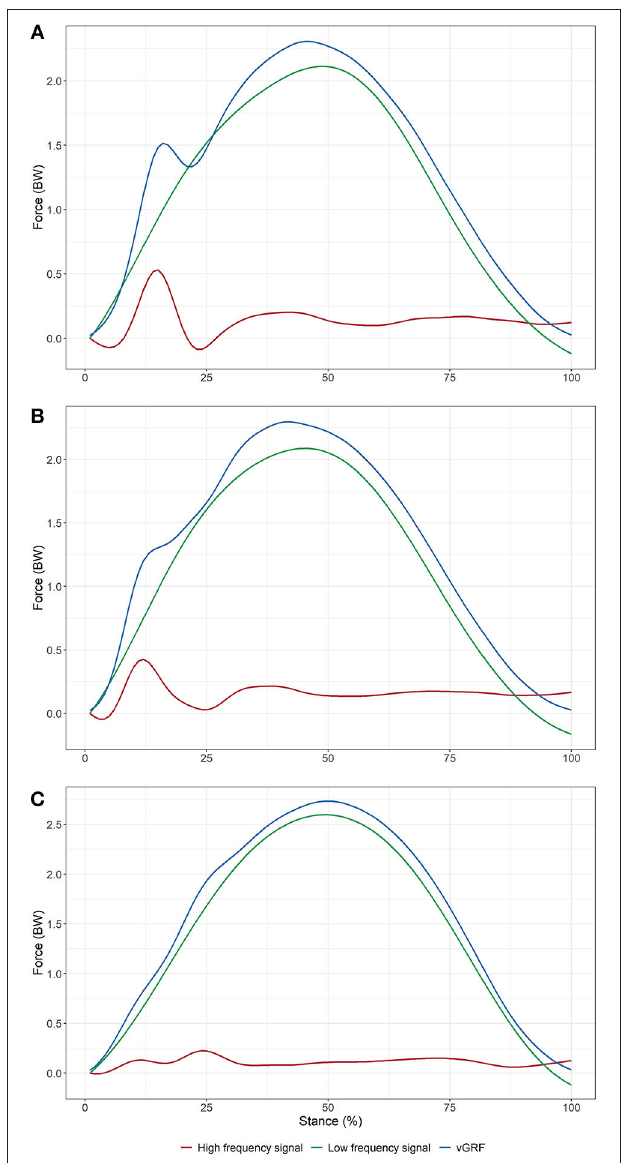
FIGURE 2 | Exemplary ensemble-averaged curves from three participants with 100% (A) , 50% (B) and 0% (C) of their steps with an impact peak identified on the vertical GRF signal, respectively. Blue line is the participant’s ensemble-averaged mean of the vertical GRF signal (vGRF), red line and green line are the reconstructed high and low frequency signal,